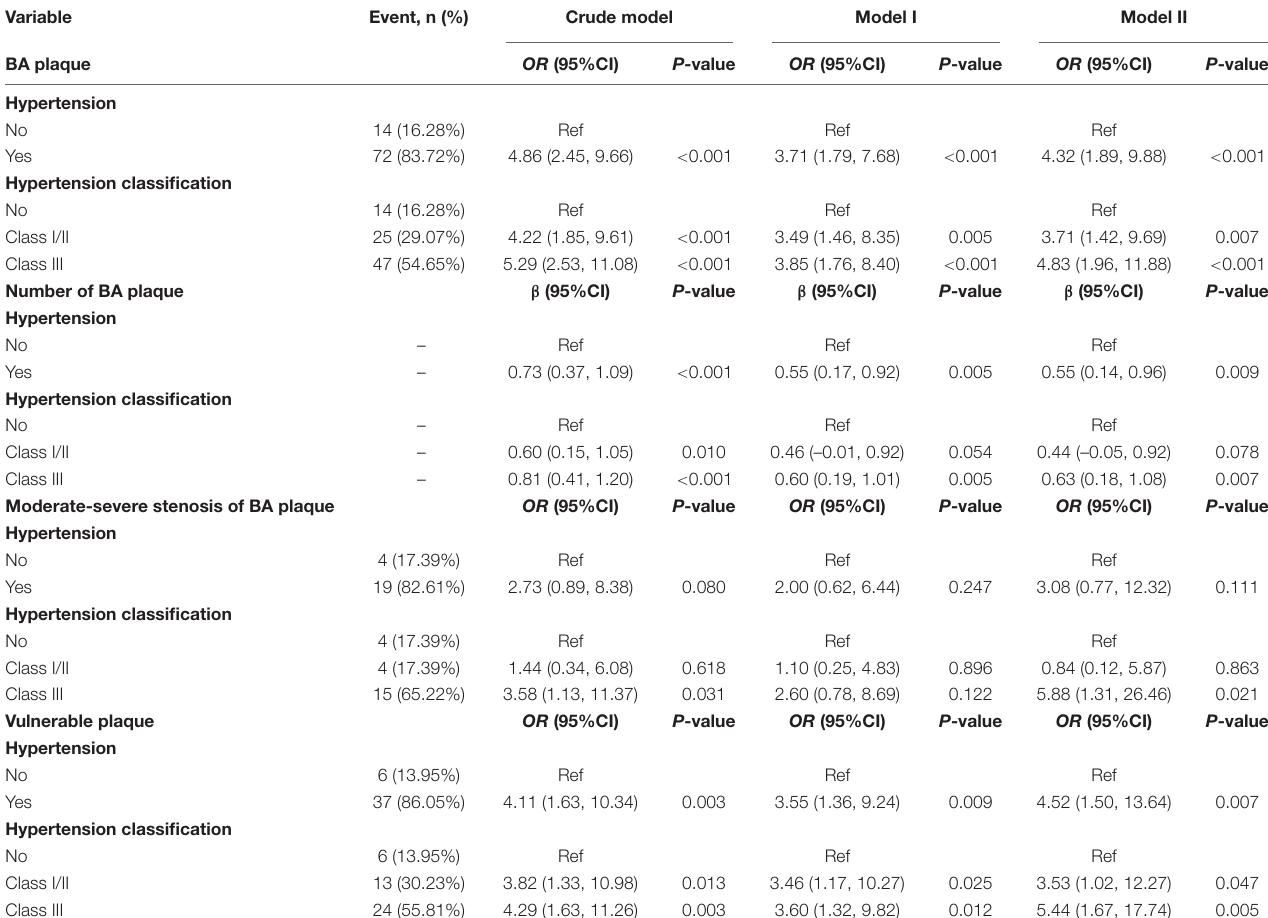
TABLE 3 | Relationship between hypertension and BA plaque and vulnerable plaque in different models. Variable Event, n (%) Crude model Model I Model II